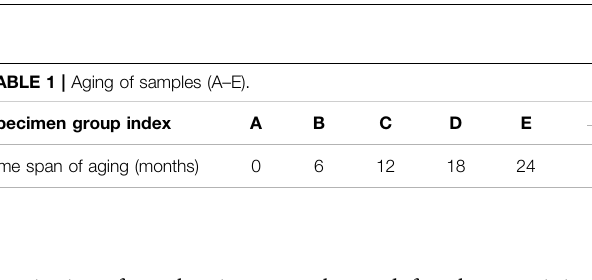
Frontiers in Materials |